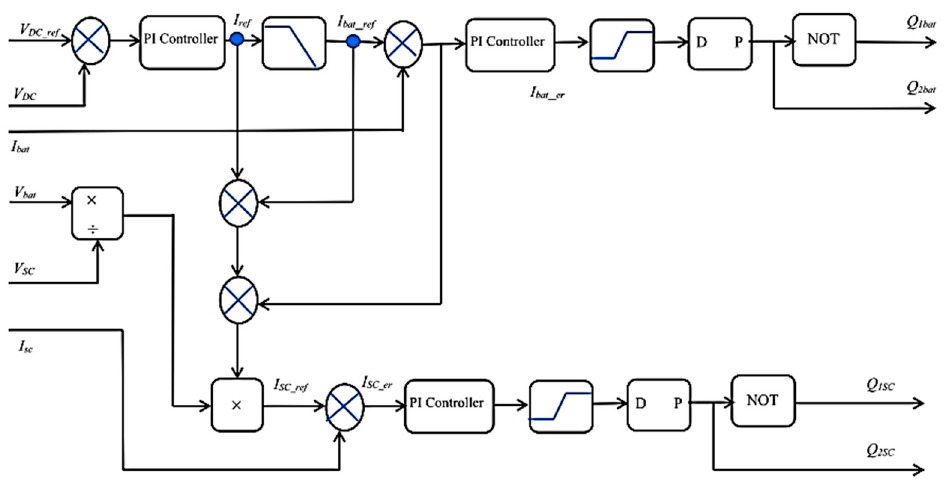
Figure 9. Schematic diagram representation of battery and supercapacitor multi-loop PI controller.